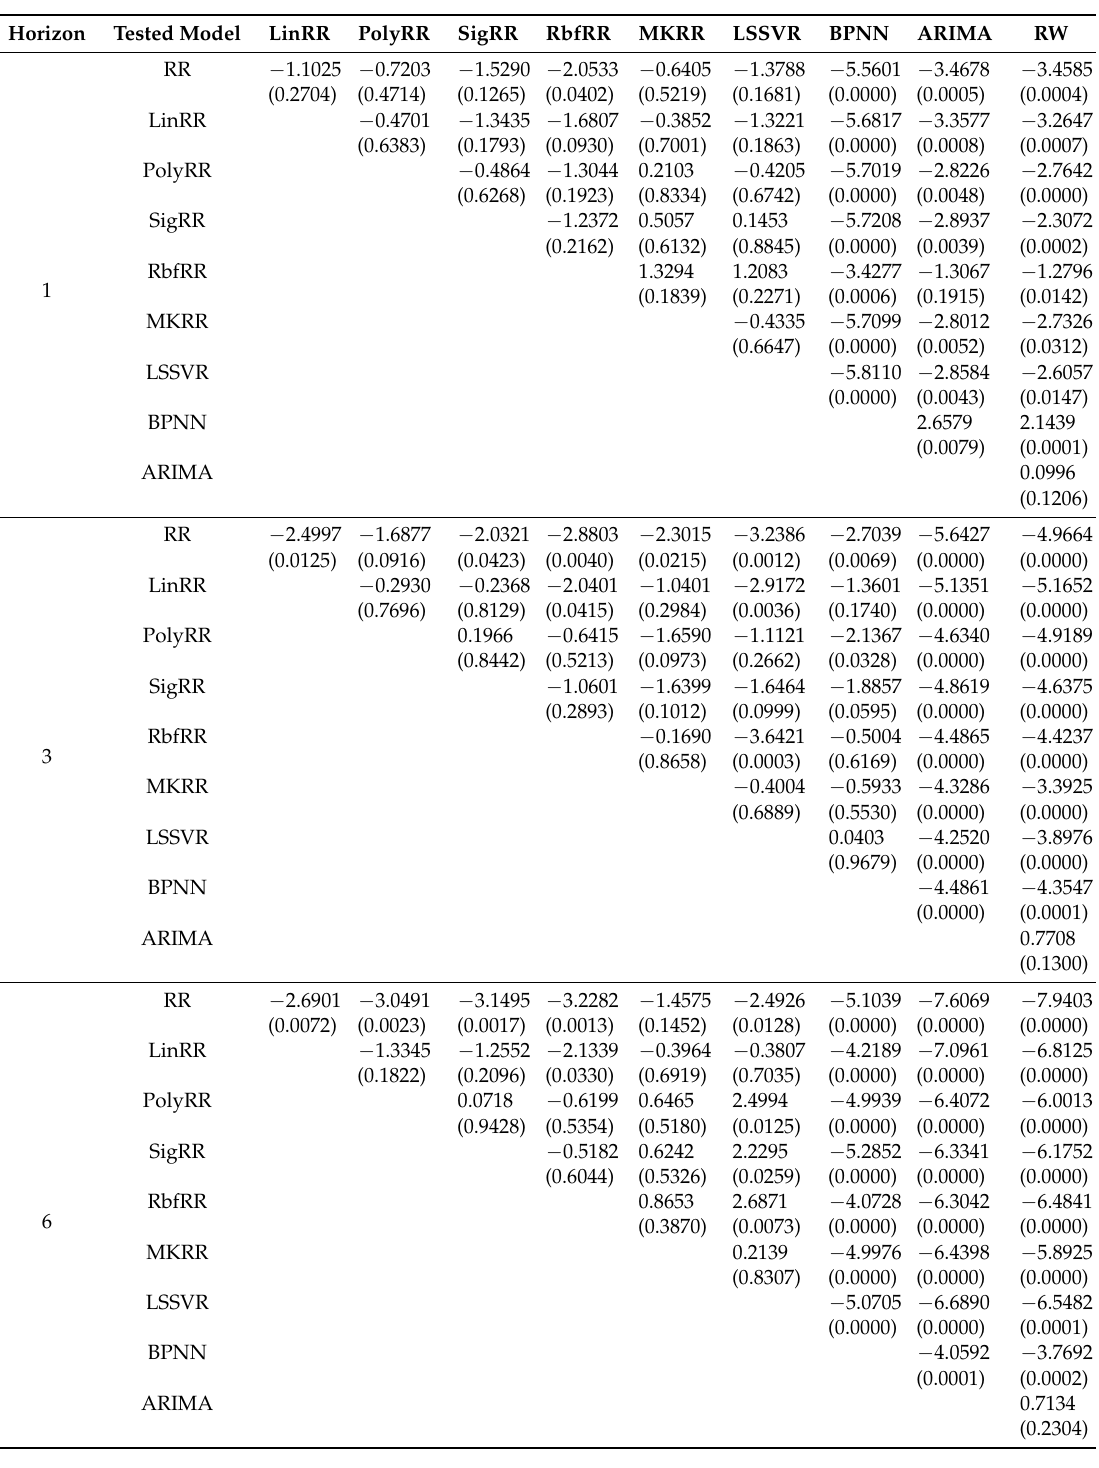
Table 3. The Diebold-Mariano (DM) test results of single